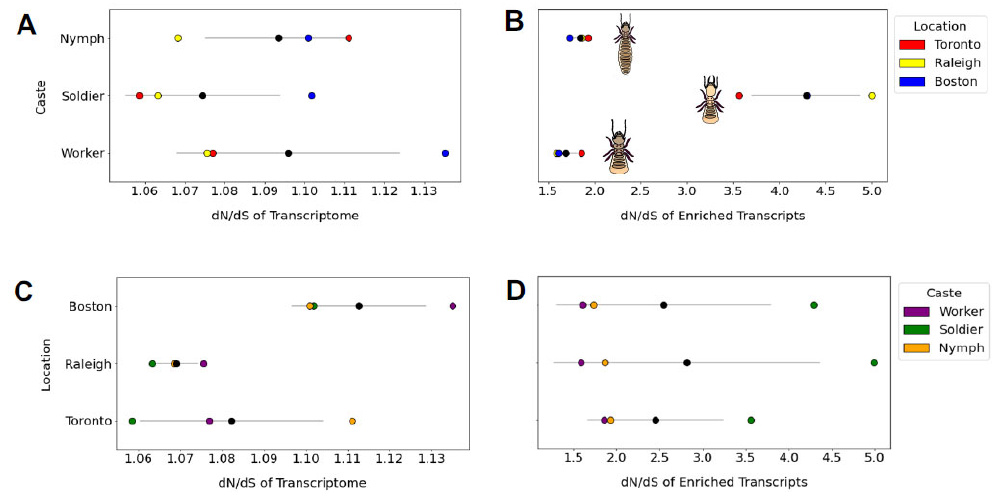
Figure 6. The d N /d S ratios of whole transcriptome and a subset of n = 230 caste ‐ specific transcripts are grouped by caste or population. For each graph, mean and standard deviation are displayed as a black circle and grey line, respectively. We observed no transcriptome ‐ wide differences in mean d N /d S between castes (shown in ( A )). However, when caste ‐ specific transcripts were tested separately ( B ), we found d N /d S of soldier ‐ expressed genes to be significantly higher than d N /d S for genes uniquely expressed in nymphs (mean difference = 2.45, Tukey’s post hoc test p = 0.001) or workers (mean difference = 2.599, p = 0.01). We found no difference between populations in mean d N /d S at the whole ‐ transcriptome ( C ) or caste ‐ specific transcriptome ( D ) level.